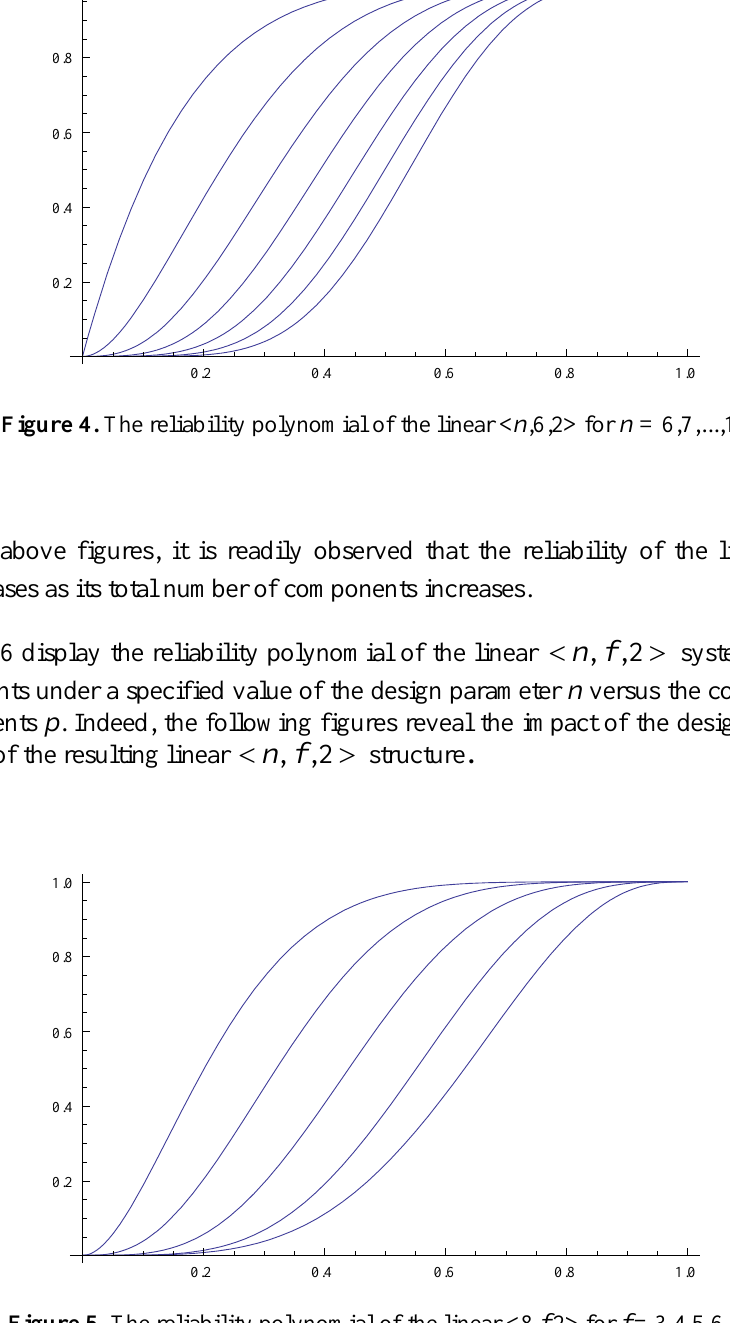
Figure 5. The reliability polynomial of the linear <8, f ,2> for f =